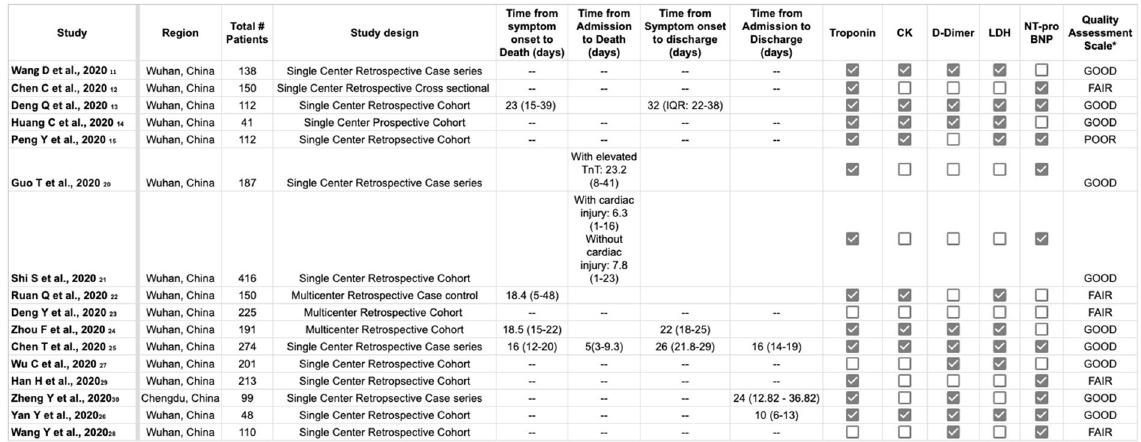
Table 1. Clinical characteristics and laboratory markers of patients affected by the coronavirus disease 2019 (COVID-19), in the included studies. *Newcastle–Ottawa Quality Assessment Scale. Poor < 4, Fair 5–6, Good >